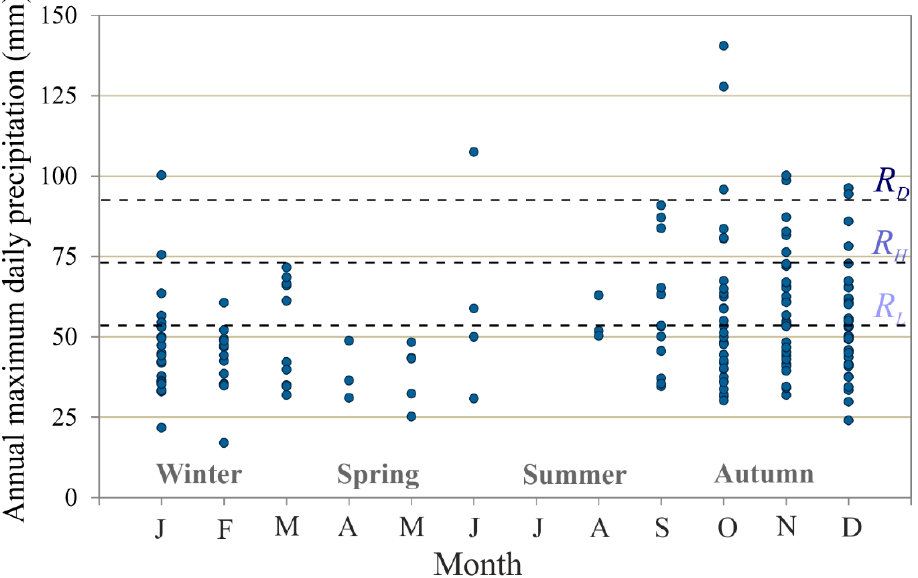
Figure 5. Monthly distribution of the volume (mm) of the annual maximum daily precipitation compared with the estimated risk values ( R L = 53.7 mm, R H = 73.2 mm and R D = 92.7 mm).